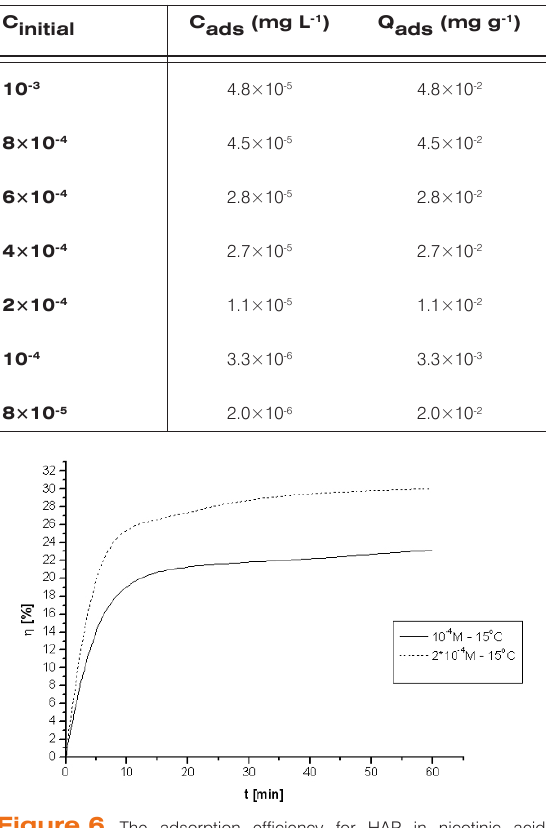
Figure 6. The adsorption efficiency for HAP in nicotinic acid solutions 10 -4 M (solid line) and 2×10 -4 M (dashed